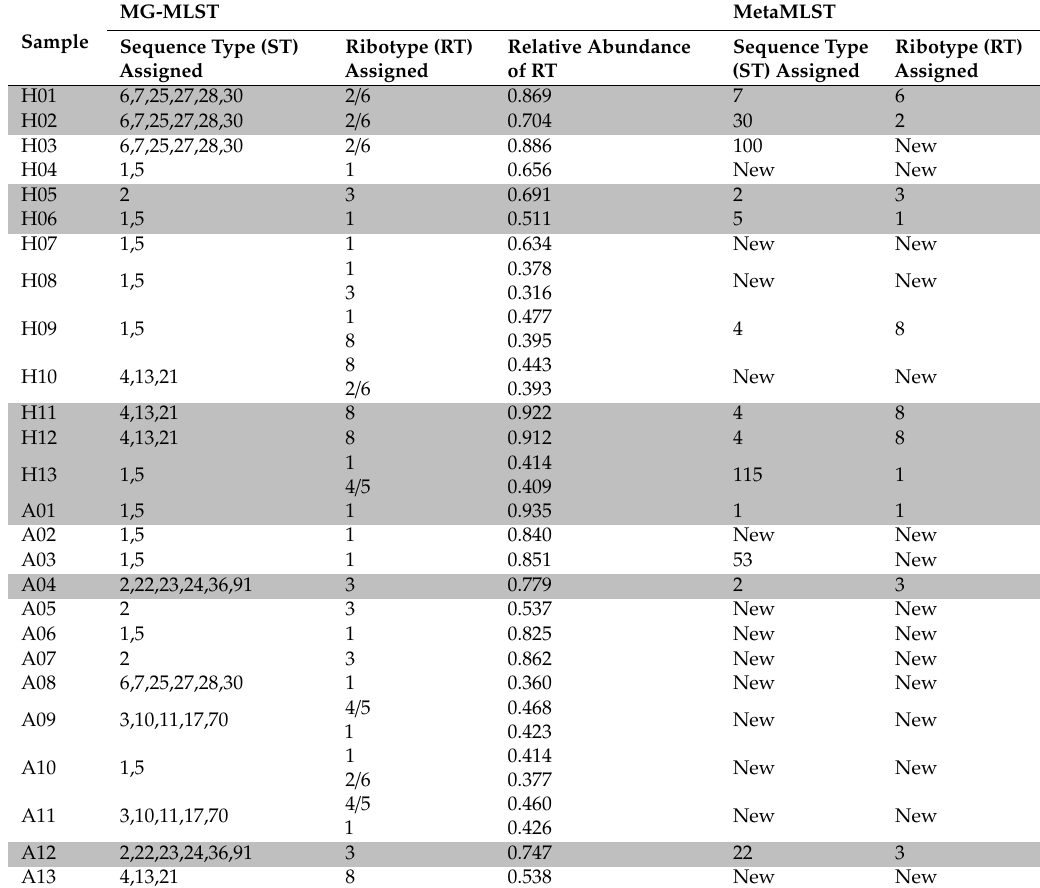
Table 1. Comparison of top strain assignment between MG-MLST and